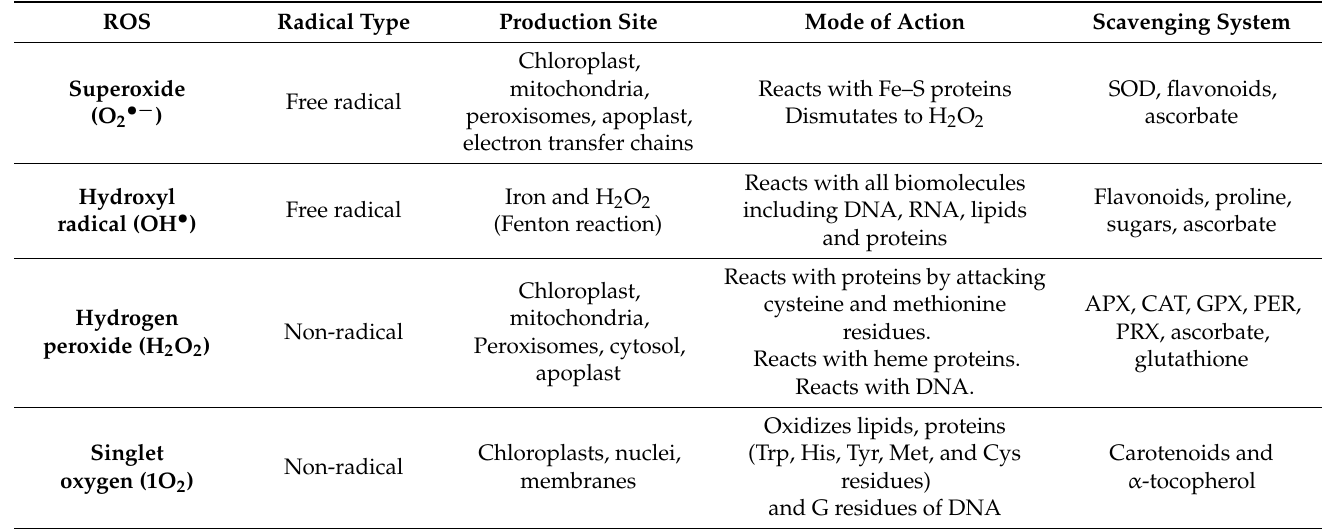
Table 1. Types of reactive oxygen species (O 2 •− , OH • , H 2 O 2 and 1O 2 ), mode of action and scaveng- ing